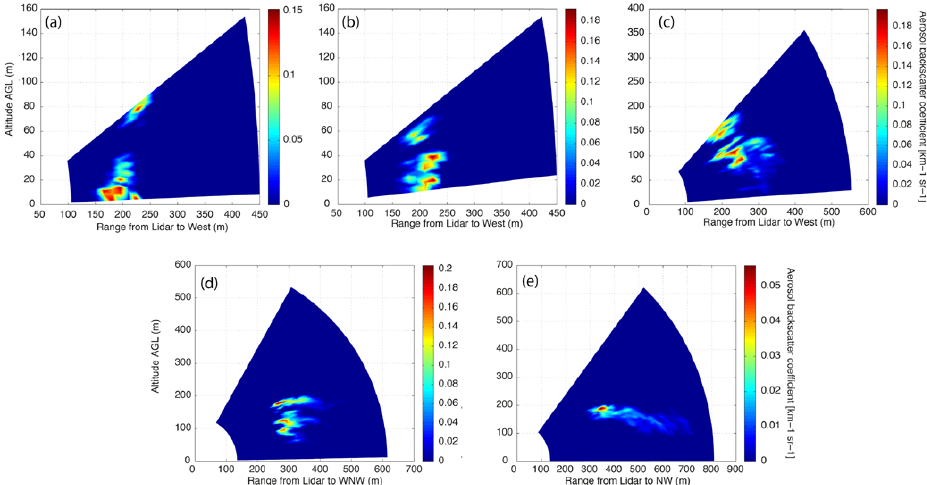
Fig. 5. Vertical cross-section of backscatter coefficient along azimuth (a) 265°at 10:27–10:29UTC (scan 1), (b) 270 ◦ at 10:30–10:32UTC (scan 2), (c) 280 ◦ at 10:33–10:35UTC (scan 3), (d) 285 ◦ at 10:36–10:39UTC (scan 4), and (e) 315 ◦ at 10:41–10:43UTC (scan